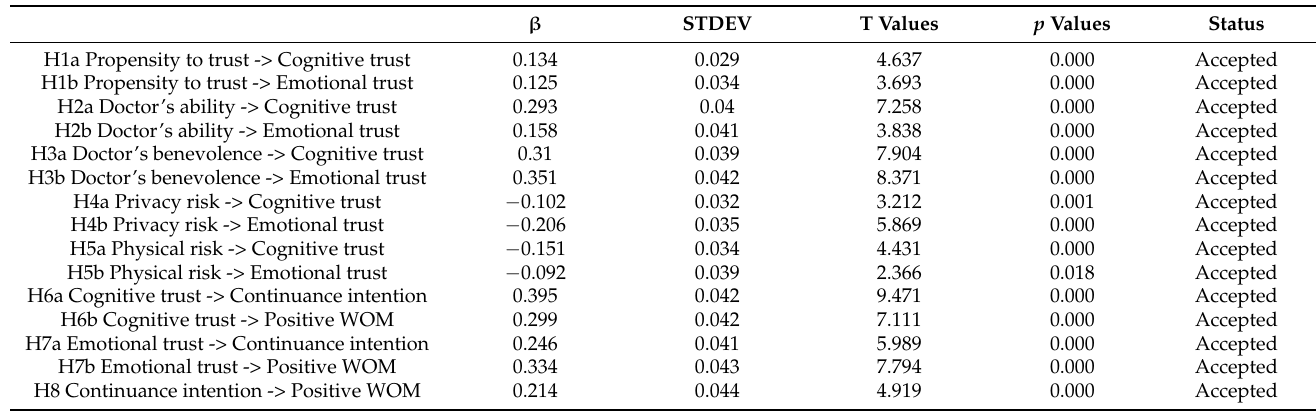
Table 7. Results of Path Coefficients.